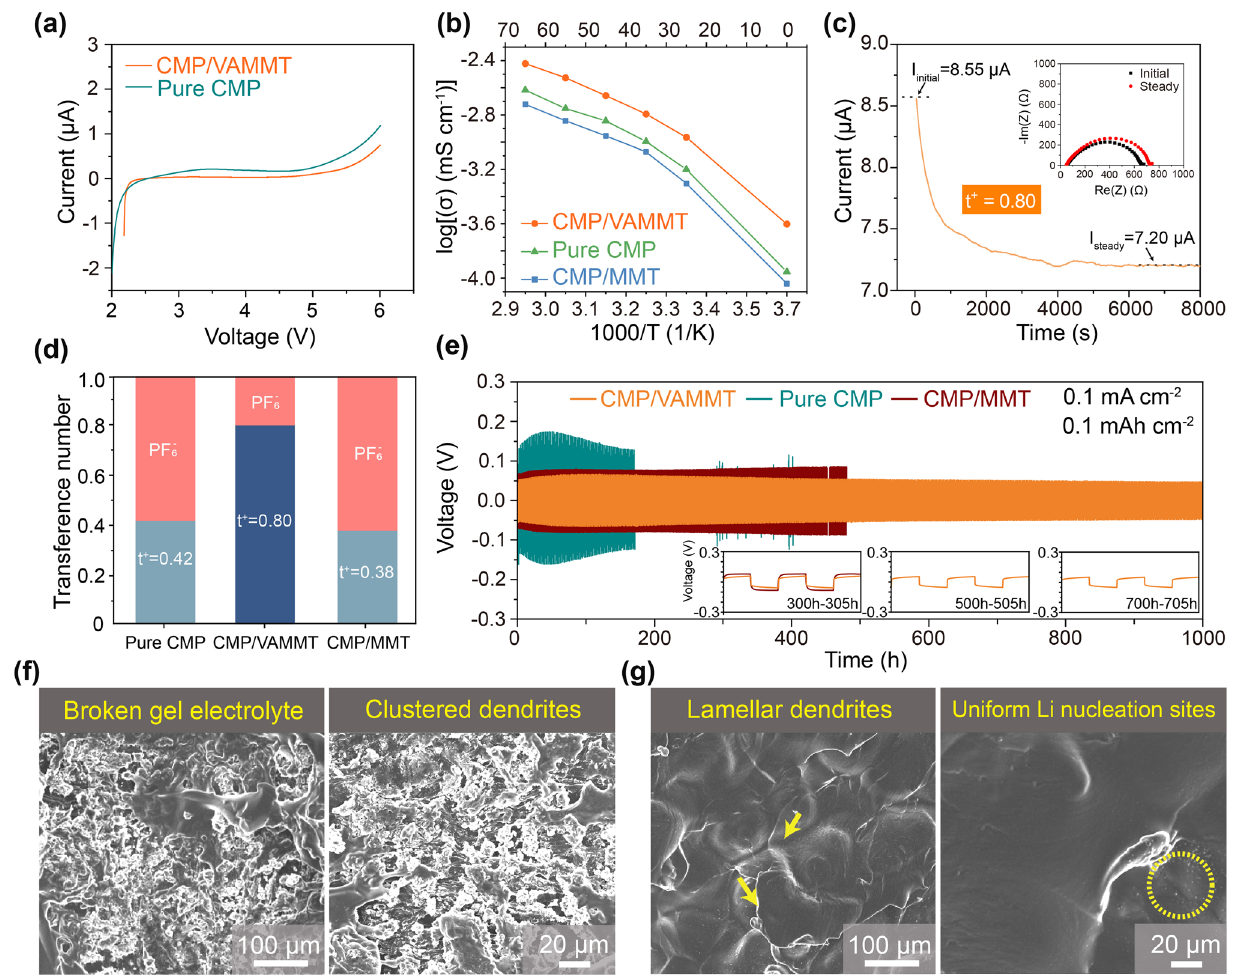
Fig. 3 Electrochemical properties and stability of CMP/VAMMT. a Linear sweep voltammetry of CMP/VAMMT and the pure CMP at a sweep rate of 1 mV s −1 . b Arrhenius ionic conductivity (σ) plots of CMP/VAMMT, CMP/MMT and pure CMP. c Current variation with time during polarization of a Li/CMP/VAMMT/Li symmetric cell (inset: the initial and steady-state AC impedance). d The Li + transference number of dif- ferent electrolytes. e Long-term cycling of symmetrical Li//Li cells with CMP/VAMMT, CMP/MMT and pure CMP at 30 °C (inset: voltage pro- file at the 300th-305th, 500th-505th and 700 th -705 th , respectively); SEM images of cycled Li electrodes collected from symmetrical Li//Li cells utilizing f pure CMP or g CMP/VAMMT GPEs after 20 cycles at 0.1 mA cm −2 , 0.1 mAh cm −2 ; these tests are all carried out at 30